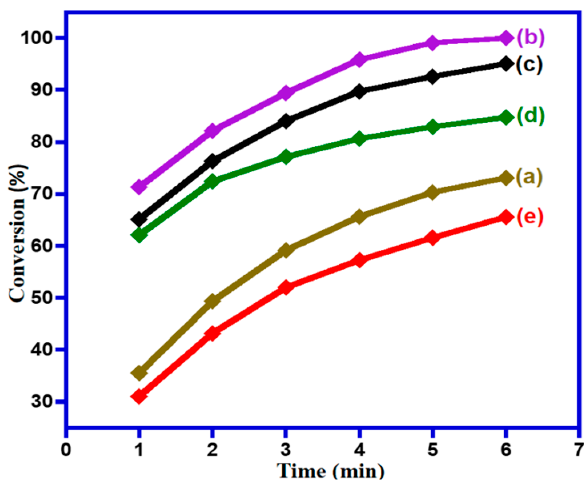
Figure 7. Graphical representation of PhCHO oxidation over ( a ) MnCO 3 –(1%)ZrO 2 , ( b ) (1%)NDG/MnCO 3 –(1%)ZrO 2 , ( c ) (3%)NDG/MnCO 3 –(1%)ZrO 2 , ( d ) (5%)NDG/MnCO 3 –(1%)ZrO 2 and ( e ) (7%)NDG / MnCO 3 –(1%)ZrO 2 catalysts.